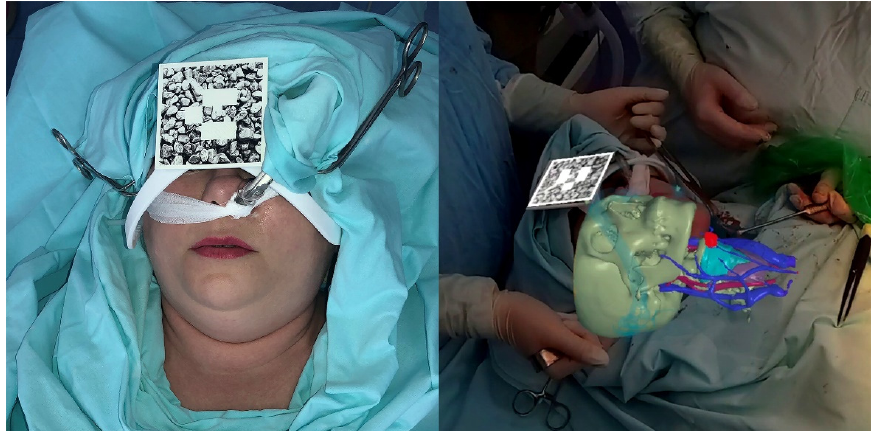
Figure 8. Referencing the position of the patient’s head in the operating room using a navigation frame ( left ). Results of overlaying the 3D model of anatomical structures on the patient, as seen from the mixed reality glasses ( right ).